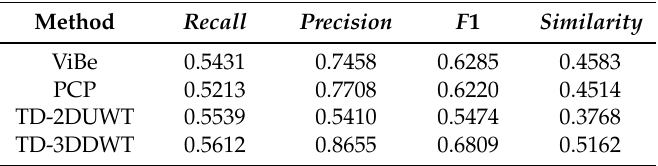
Table 11. Comparison of average metrics for the buffet restaurant sequence.